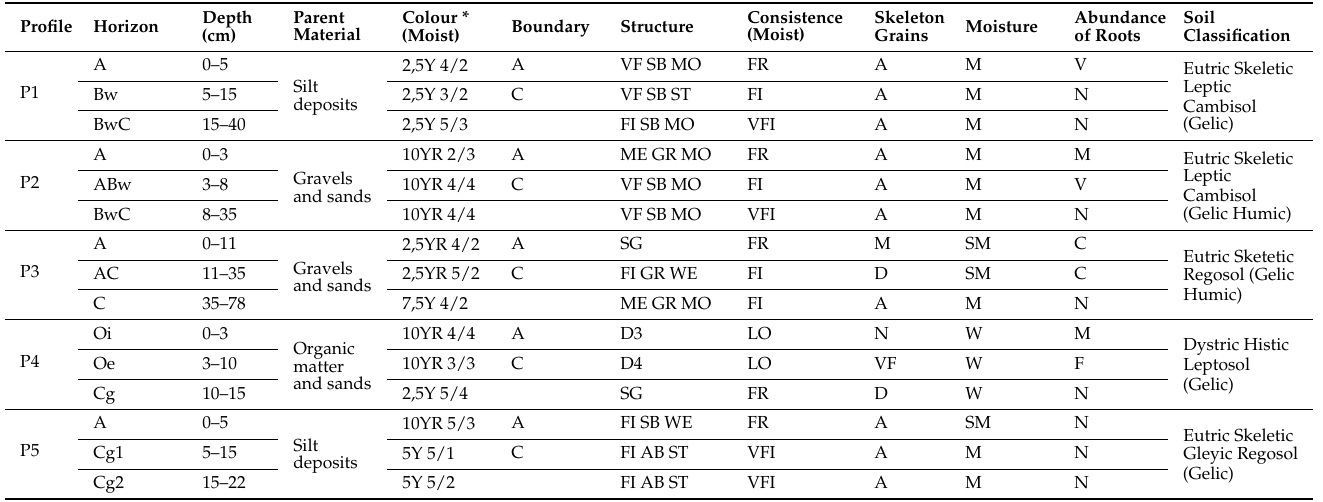
Table 2. A morphological description of studied soils and their systematic position according to the WRB classification [62].